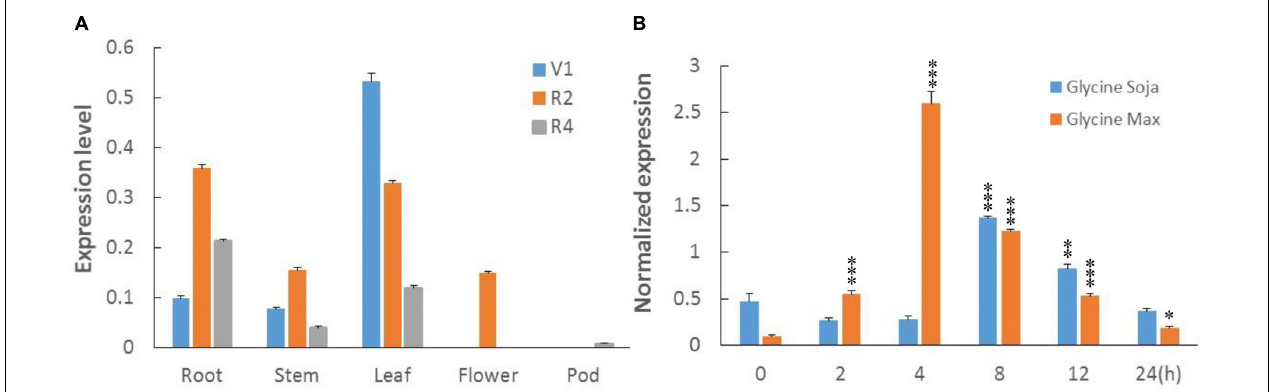
FIGURE 3 | Transcriptional profiles of GmWRKY49. (A) Tissue-specific transcript abundance of GmWRKY49 in roots, stems, leaves, flowers, and pods at different developmental stages, the first trifoliate stage (V1), full bloom stage (R2), and full pod stage (R4). (B) Expression patterns of GmWRKY49 in roots of G. max and G. soja under 0 and 200 mM NaCl stress at different time 0, 2, 4, 8, 12, and 24 h. P -values were calculated using Student’s t -test and ∗ P < 0.05, ∗∗ P < 0.01, and ∗∗∗ P < 0.001 compared with control and 0 h,